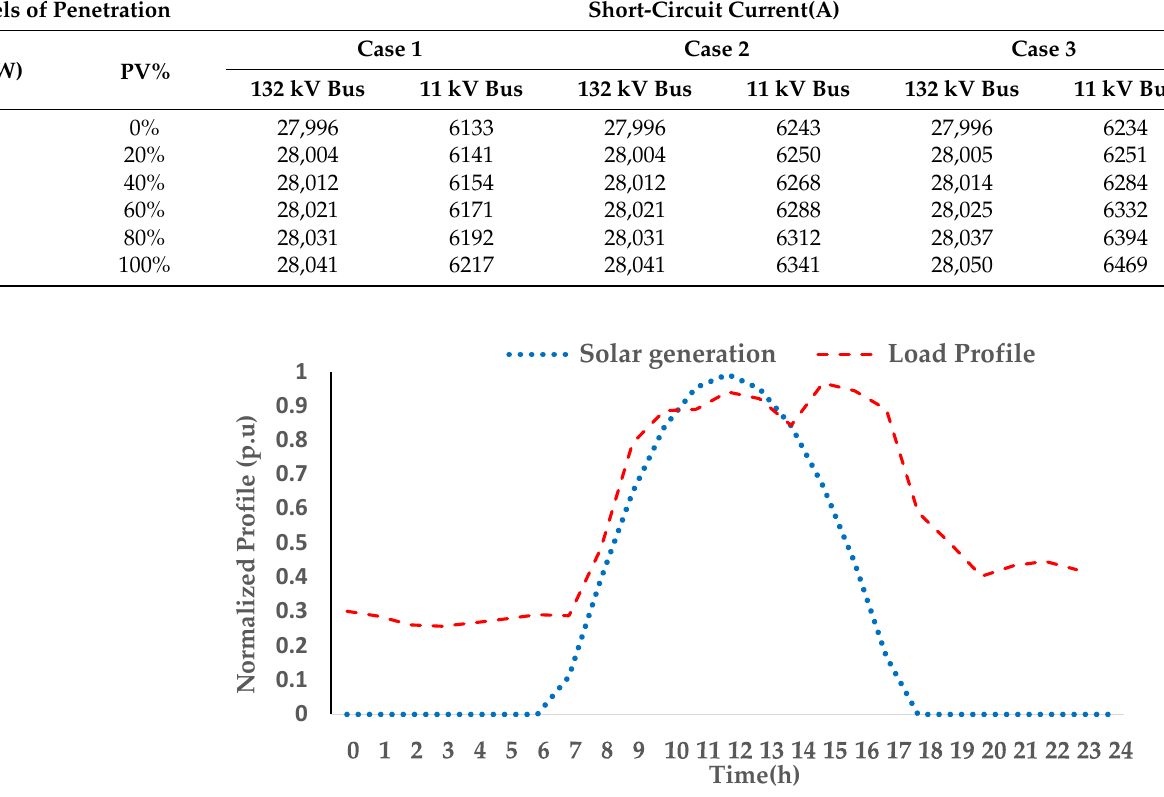
Table 4. A comparison of short-circuit currents during a period of peak load.